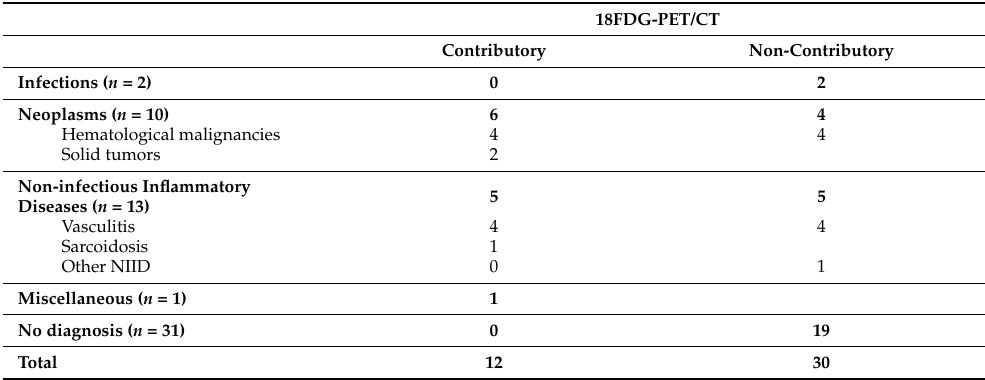
Table 4. Results and contribution of 18FDG-PET/CT to the